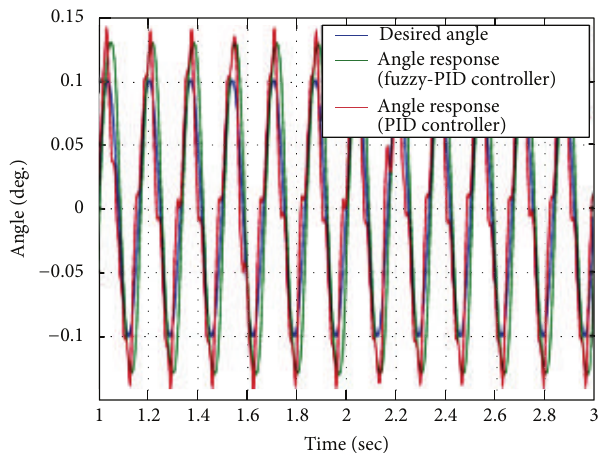
Figure 11: Angle response of PID and fuzzy-PID controller.